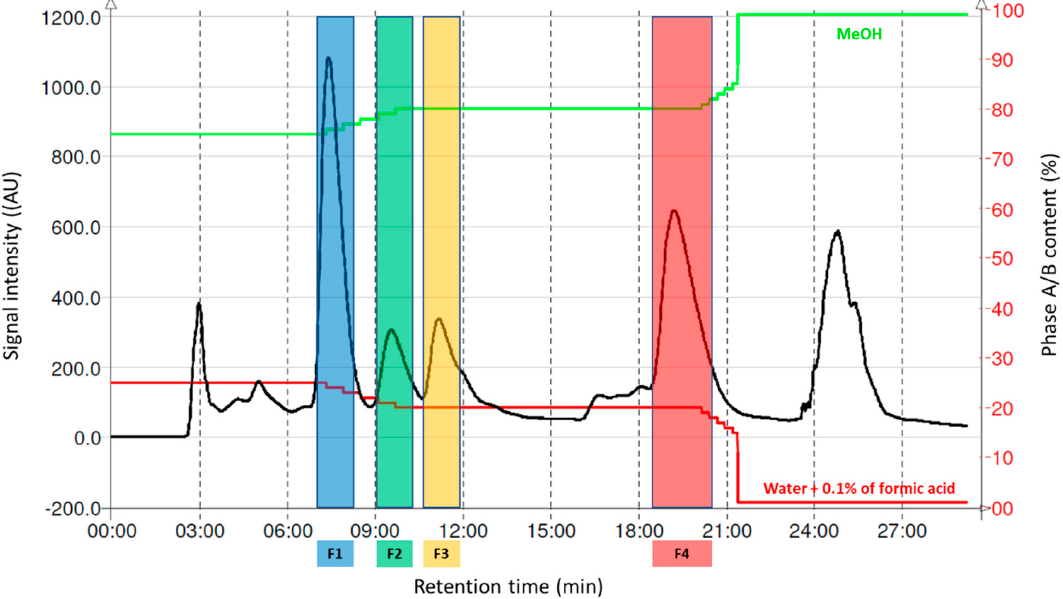
Figure A1. Preparative LC chromatogram of M. alba root extract with fractions F1–F4 corresponding to moracenin B (F1), moracenin A (F2), kuwanon C (F3) and morusin (F4).